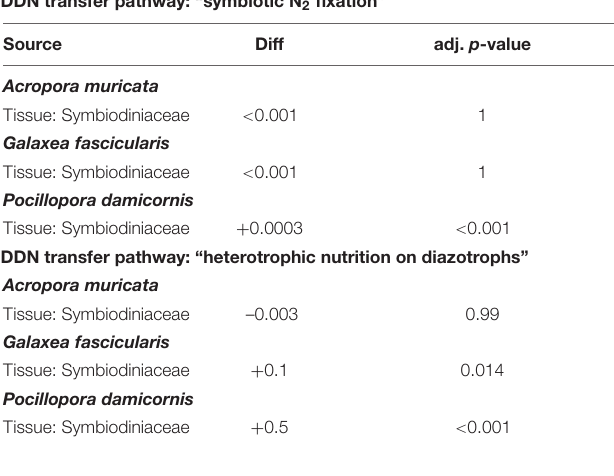
TABLE 4 | Results of a two-way factorial ANOVA testing the effect of coral species, compartments and DDN assimilation rates on the DDN transfer pathway. DDN transfer pathway: “symbiotic N 2 fixation”